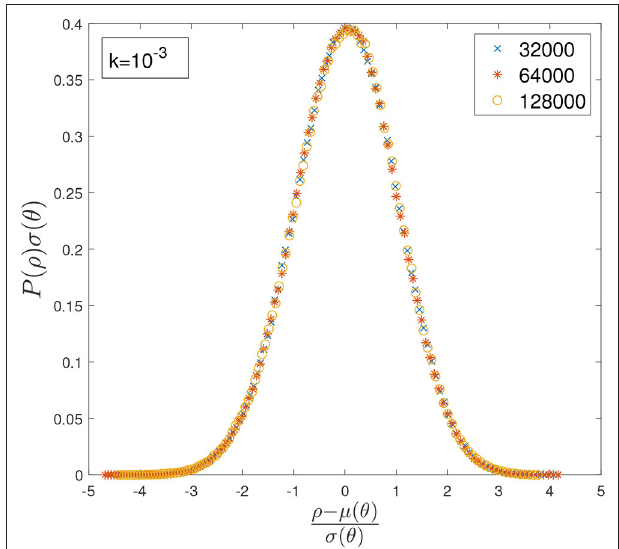
FIGURE 4 | Distribution of densities P ( ρ ) computed at different values of θ and k = 10 − 3 . The x-axis has been rescaled by θ 0.005 to align the position of the peaks at large values of θ .